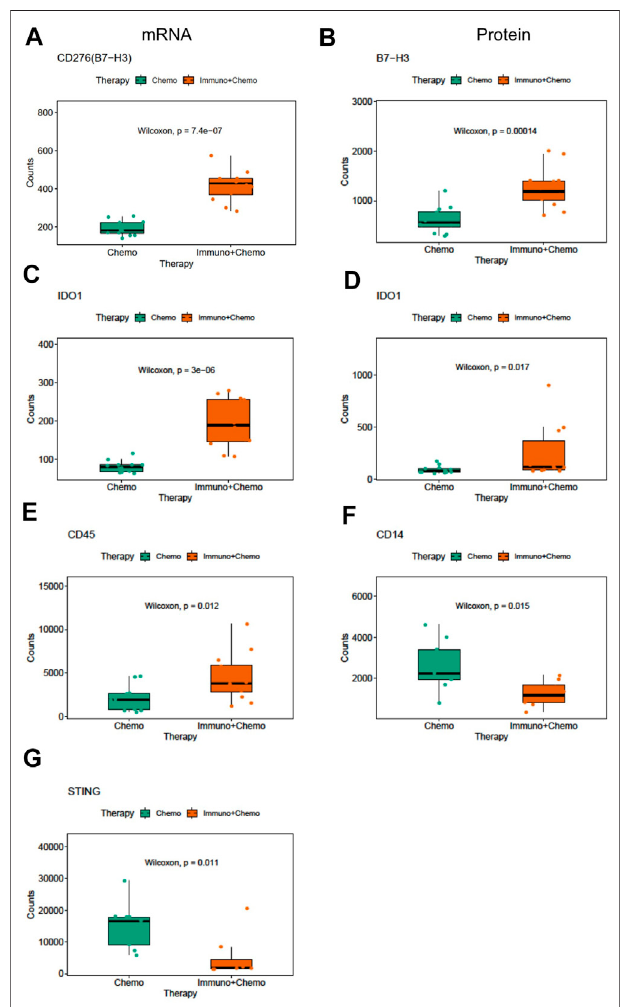
FIGURE 4 | Differentially expressed mRNA and protein markers in tumor or stroma ROIs of chemotherapy or combinational therapy patients. Boxplots of CD276 mRNA (A) and protein (B) expression in the tumor ROIs of chemotherapy or combinational therapy patients (the Mann – Whitney test p < 0.05, non-adjusted). Boxplots of IDO1 mRNA (C) and protein (D) expression in the tumor ROIs of chemotherapy or combinational therapy patients (the Mann – Whitney test p < 0.05, non- adjusted). Boxplots of CD45 (E) , CD14 (F) , and STING (G) expression in the stroma ROIs of chemotherapy or combinational therapy patients (the Mann – Whitney test p < 0.05, non-adjusted).